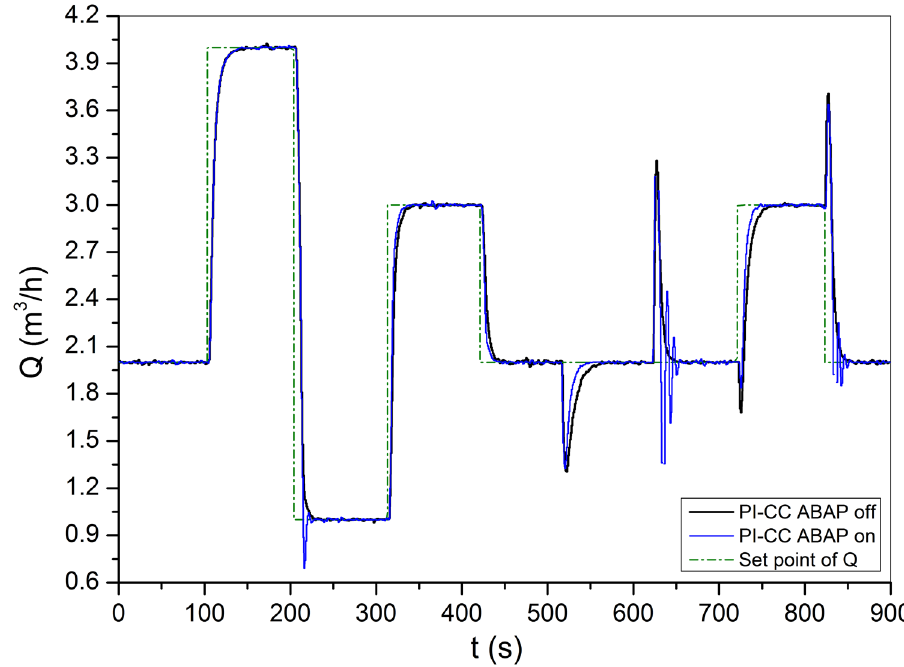
Fig. 12 Flow rate and pump power in function of time dur- ing a test with ABAB con- figured as sensitive and CAS turned